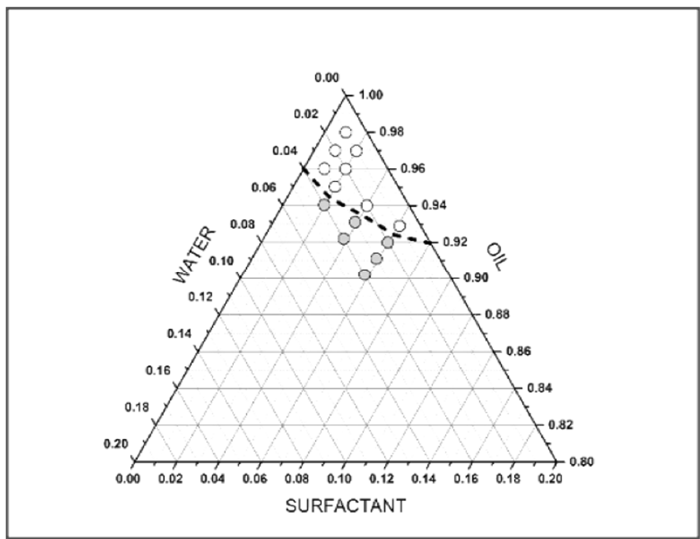
Figure 1. Properties of formulated microemulsions with different oil, water and surfactant ternary proportions. white dots represent transparent microemulsions, while grey once correspond to opaque ‐ looking ones.